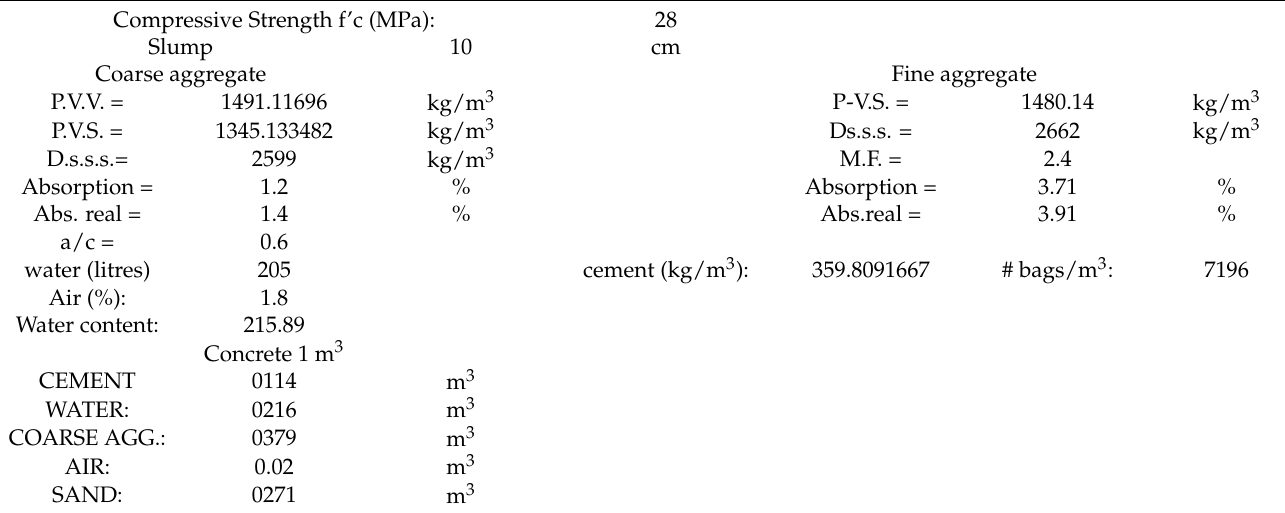
Table A1. Conventional concrete mix